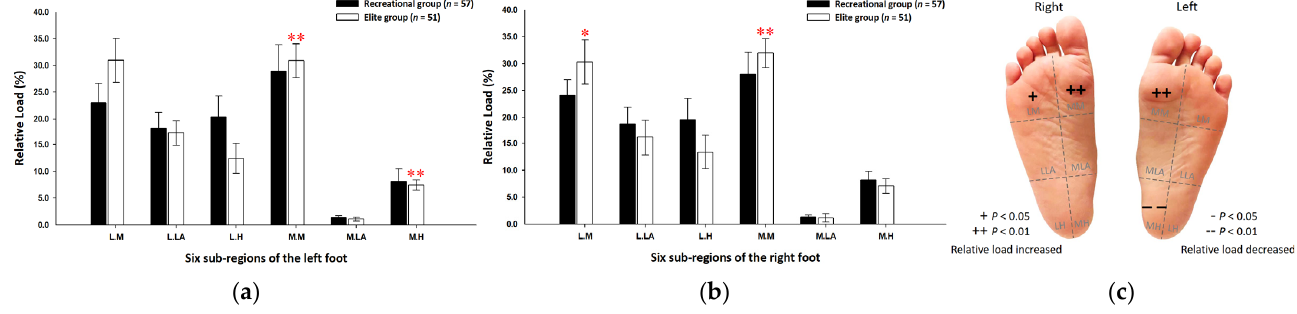
Figure 3. The plantar pressure distributions of the left ( a ) and right ( b ) feet in the six subregions during the midstance phase of walking. Description of changes in pressure distribution is illustrated in ( c ) plantar diagram. Through the independent sample t -test, * p < 0.05 and ** p < 0.01 were significantly different between both groups. The six subregions and their abbreviations are as follows: LH, lateral heel; LLA, lateral longitudinal arch; LM lateral metatarsal bone; MH, medial heel; MLA, medial longitudinal arch; and MM, medial metatarsal bone.